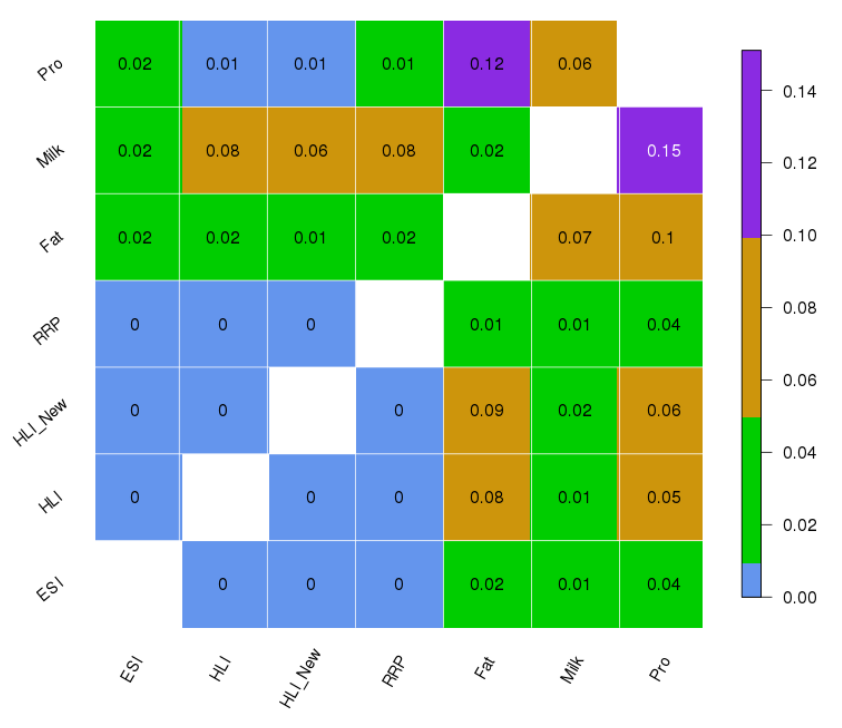
Figure 7. P -values of the correlations between milk compounds and climate indices. The upper diagonal indicates spring and the lower diagonal shows the summer p